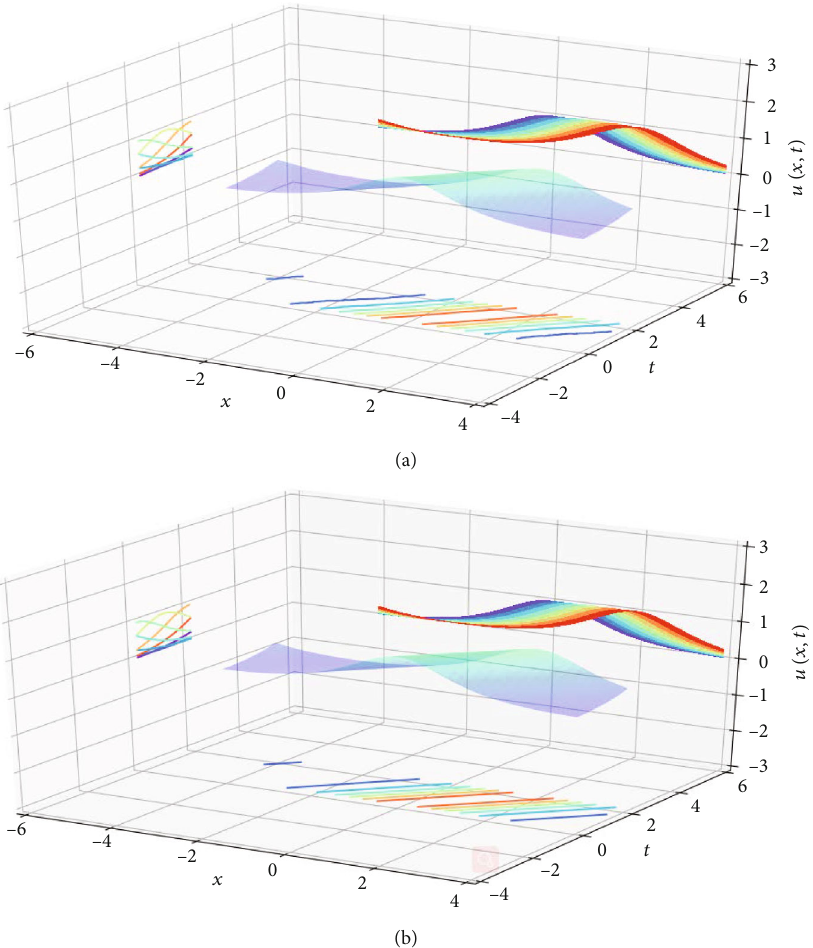
Figure 2: The projection of the exact solution (a) in the x − t , x − u , t − u direction and the projection of the predicted solution (b) in the x − t , x − u , t − u direction of the mkdv equation with initial state u ð x , 0 Þ = 2 exp ð − x Þ / ð exp ð − 2 x Þ + 1 Þ